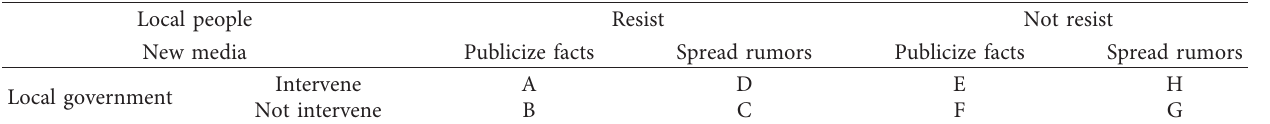
Table 3: Payment matrix of local government, new media, and local